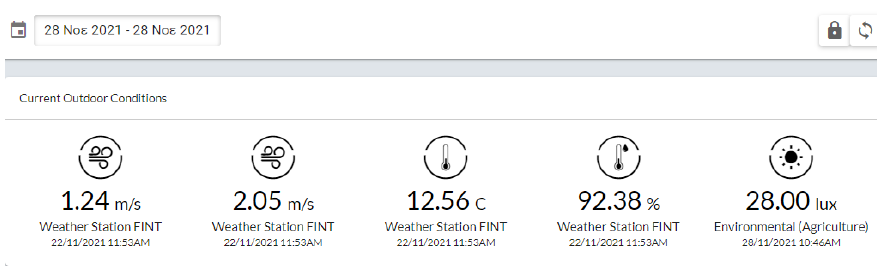
Figure 8. Outdoor-conditions monitoring and real time visualization to the